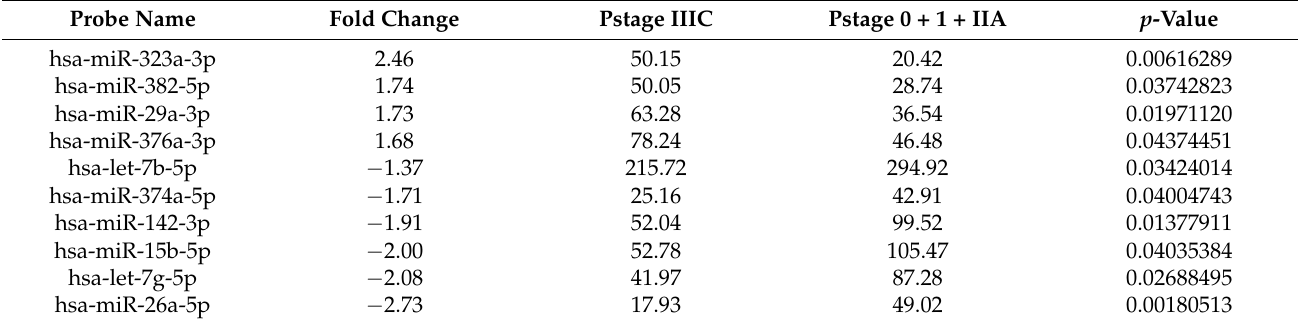
Table 2. Fold changes and associated p -value for 10 miRNAs in the discovery